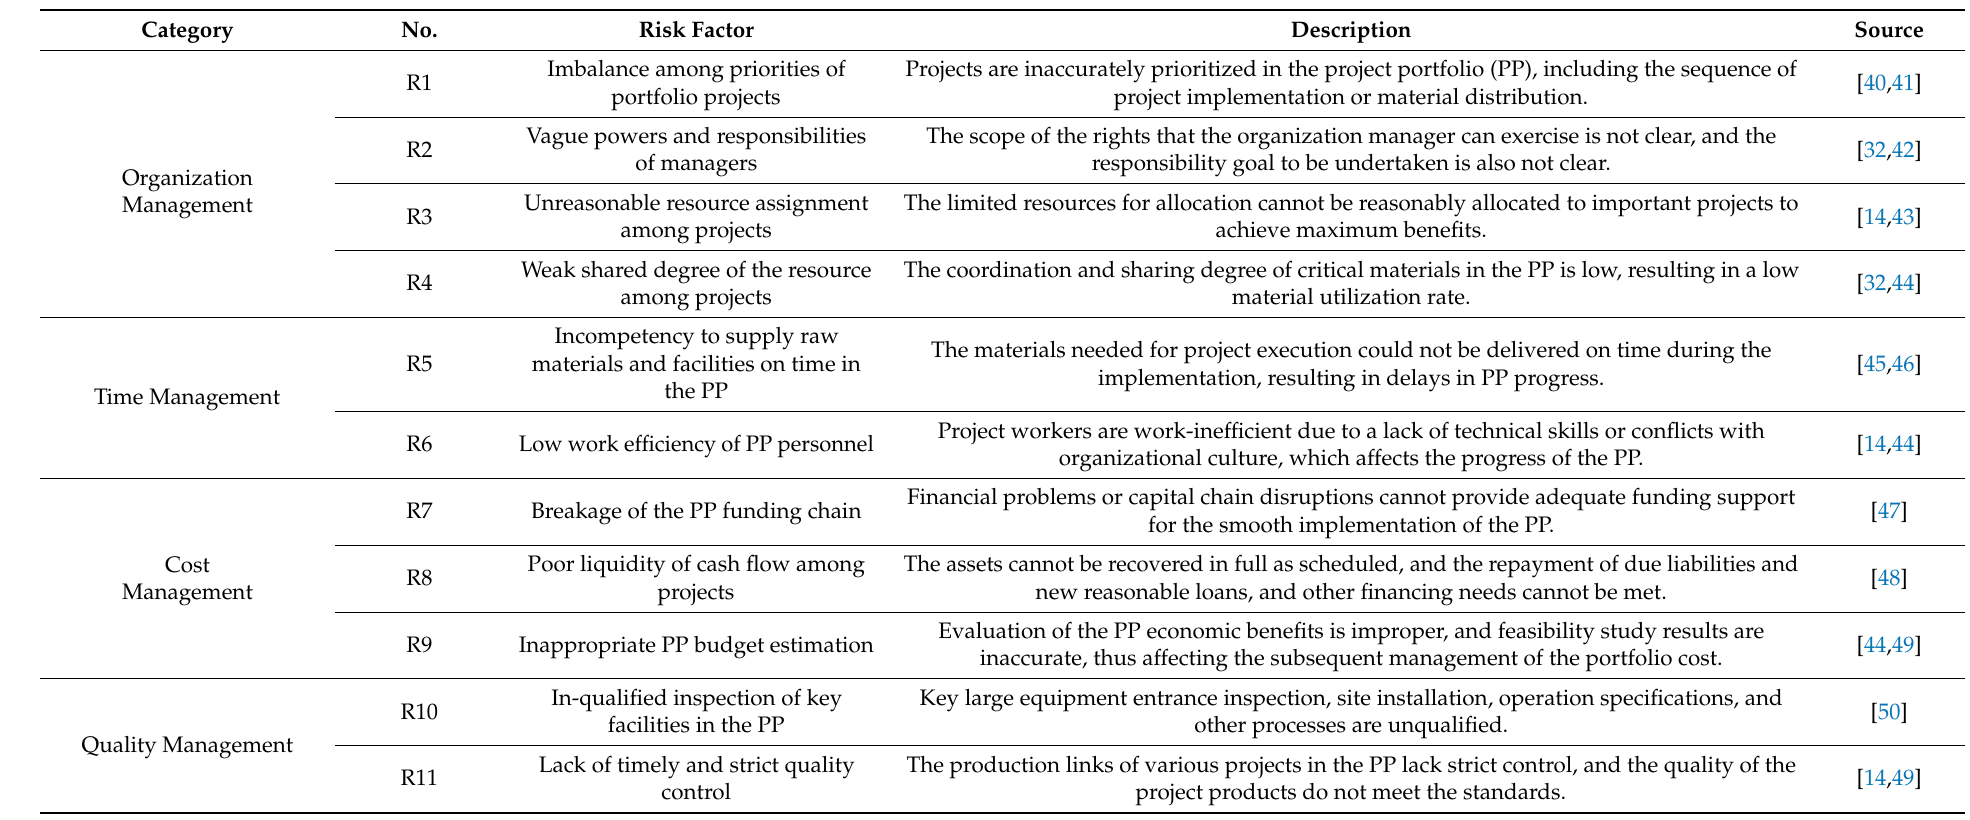
Table 1. Potential risks in